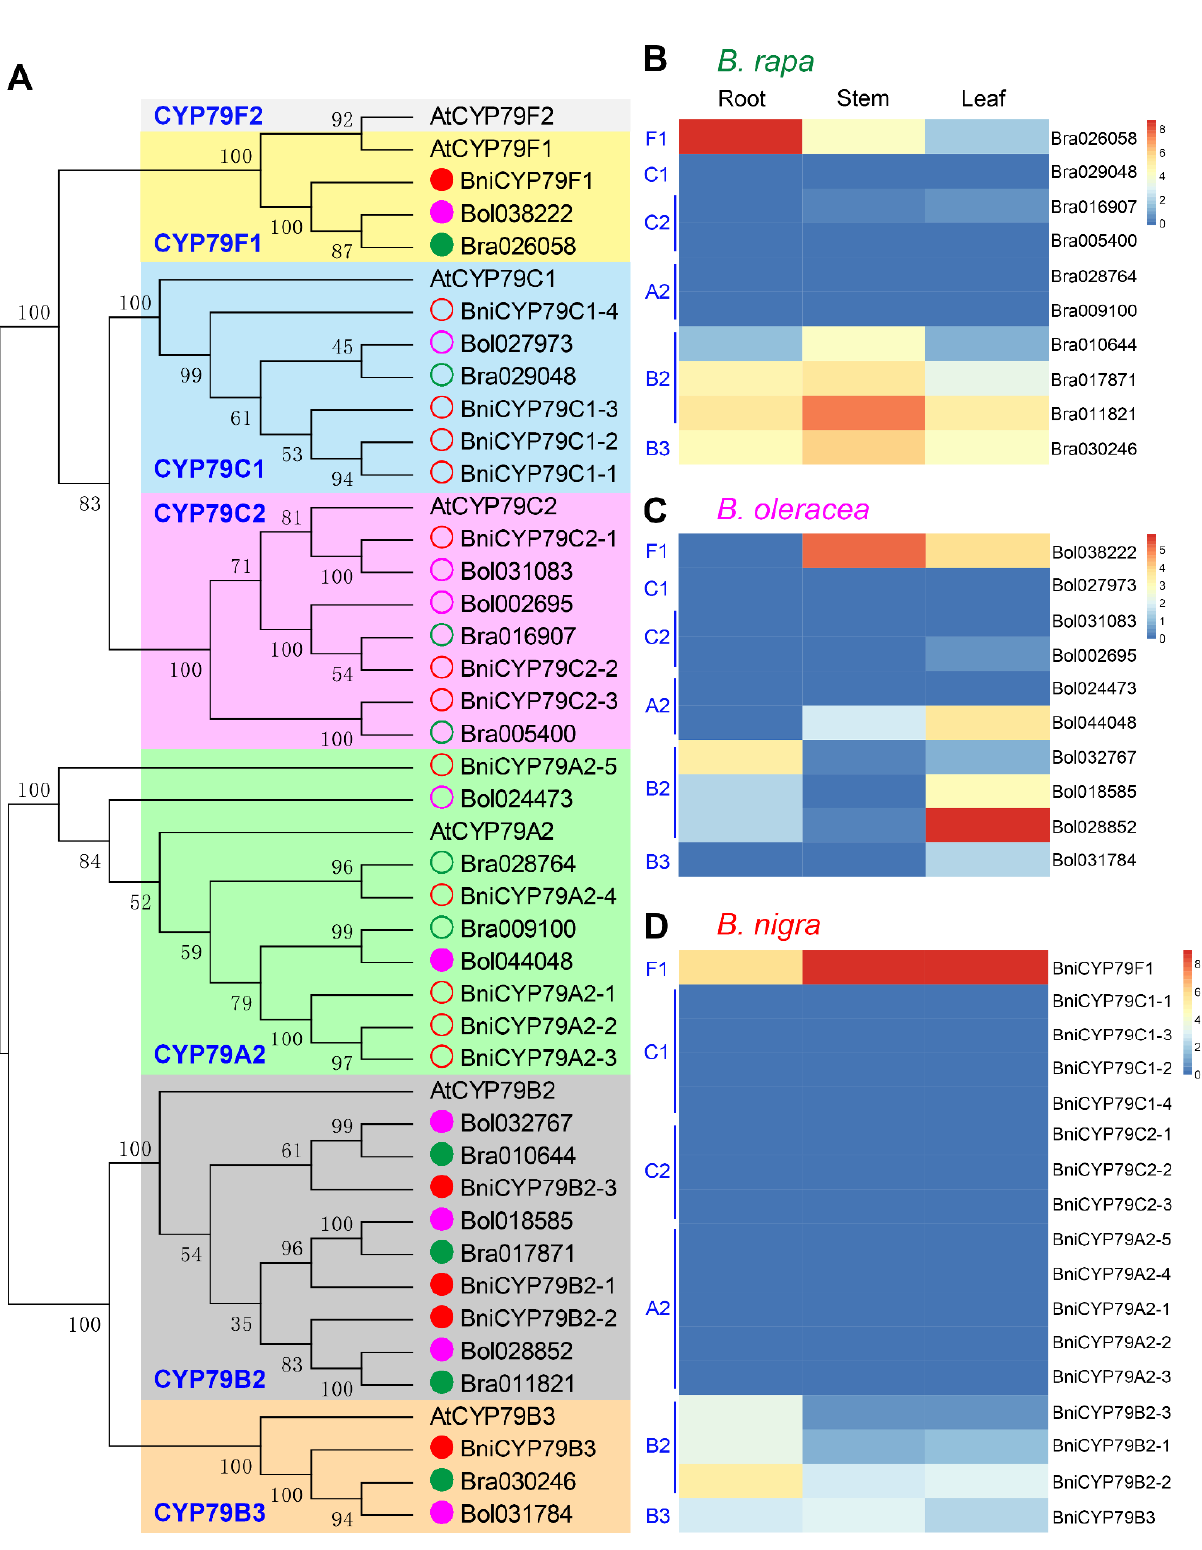
Figure 7. The phylogenetic tree and heatmap of CYP79 genes in Brassica rapa , Brassica oleracea , Brassica nigra , and Arabidopsis thaliana . ( A ), The phylogenetic tree of CYP79 genes. The CYP79 genes identified from Brassica rapa , Brassica oleracea , and Brassica nigra are indicated by green, purple, and red hollow circles or solid discs. The silenced genes are represented by a hollow circle, expressed functional genes are indicated by a solid disc. The heatmap of CYP79 genes in Brassica rapa ( B ), Brassica oleracea ( C ), and Brassica nigra ( D ). The expression data of B. rapa and B. oleracea were obtained from ref [48,49].